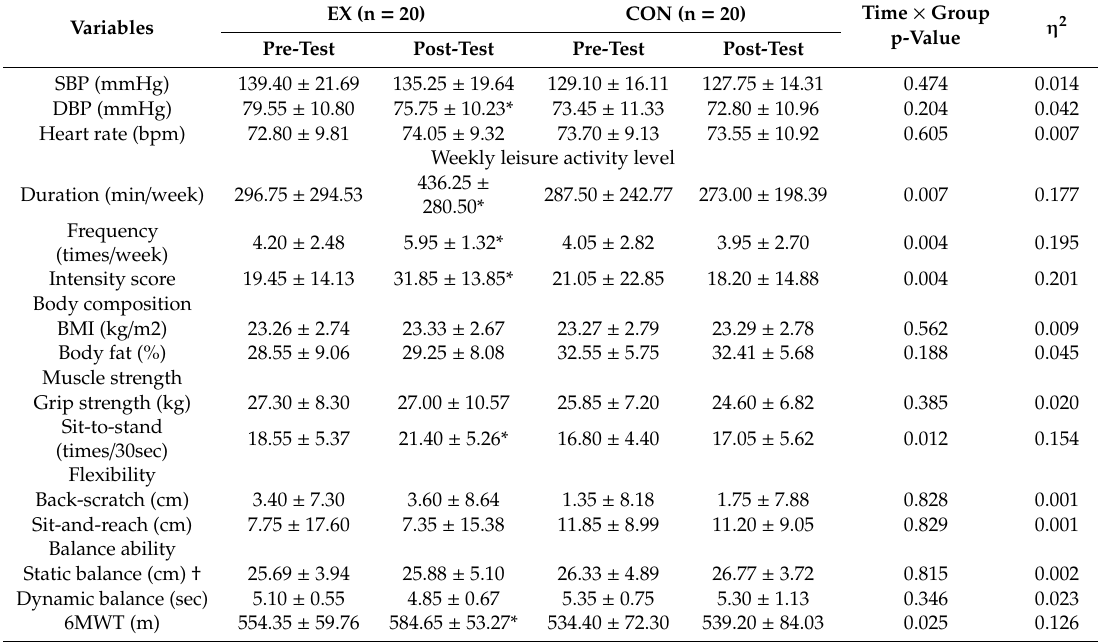
Table 2. Outcome